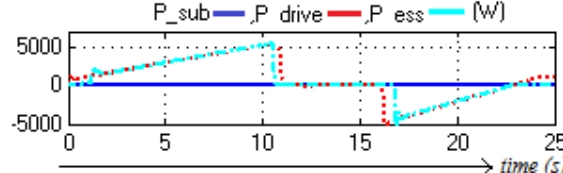
Fig. 18. Simulation diagrams for V SC = 199.5 V when C = 31.5 F and V SC = 193.41 V when C = 63 F in autonomous mode.